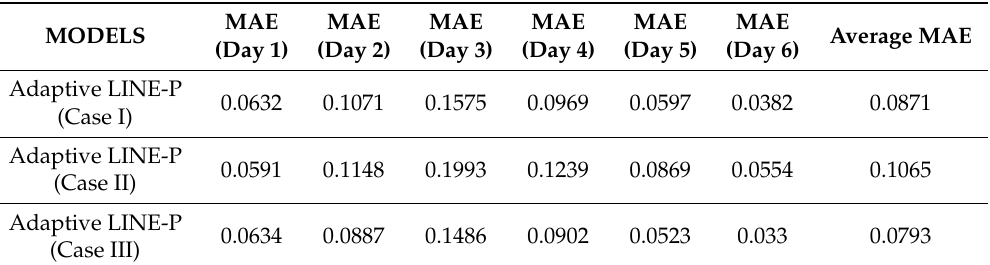
Table 2. Error comparison of adaptive LINE-P (all cases) based on the MAE for SDG&E solar energy profile.